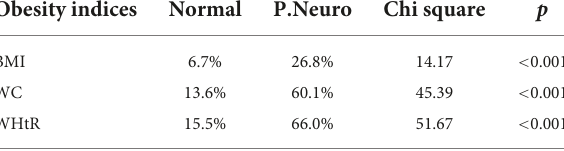
TABLE 1 Prevalence of peripheral neuropathy in persons with obesity (by different obesity indices). Obesity